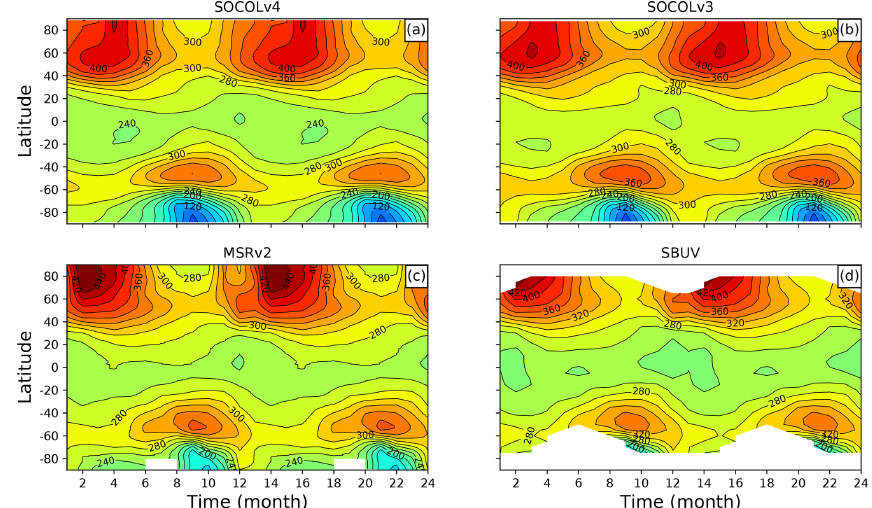
Figure 14. Seasonal cycle of total ozone simulated by SOCOLv4 (a) against SOCOLv3 (b) , MSRv2 (c) , and SBUV observations (d) averaged for the 1980–2014